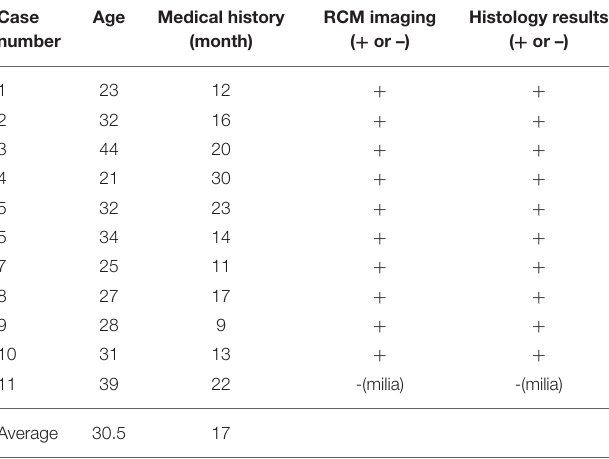
TABLE 1 | The age and medical history of the patients enrolled in the study. Case